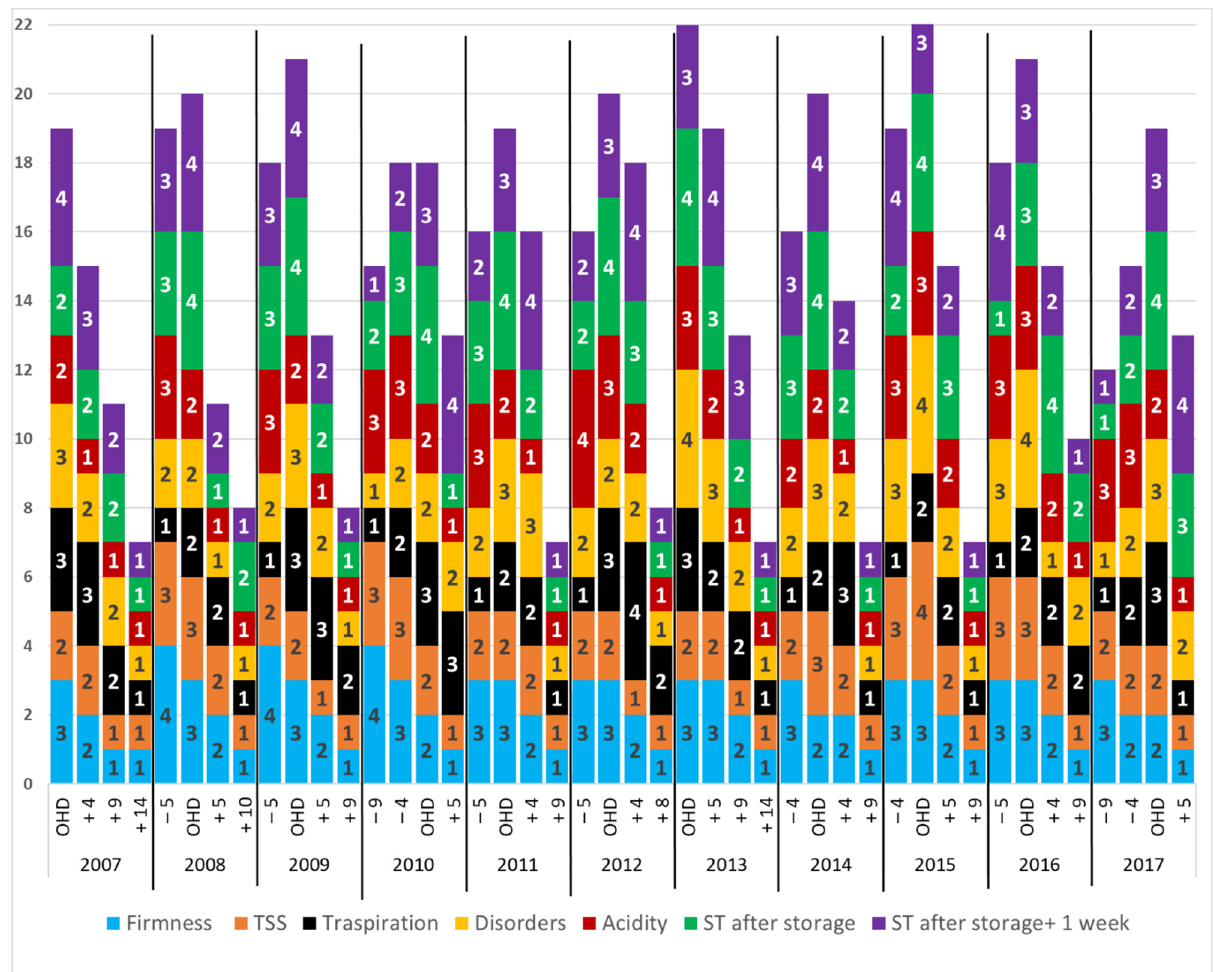
Figure 1. Assessment according to a point scale of the quality aspects of fruit samples harvested on the respective dates examined after storage in the years 2007–2017. Numbers on the bars (1,2,3,4) show scores received for each criterion following the rules described in Materials and Methods. OHD—optimal harvest date. + and − signs on the x-axis show how many days after or before OHD the harvest occurred.